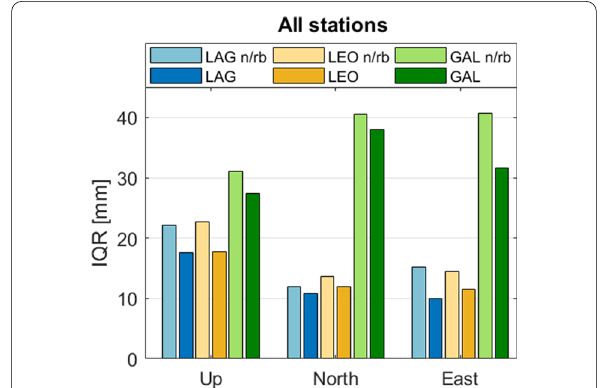
Fig. 6 Repeatability of estimated station coordinates by the means of IQR for LAGEOS (LAG), LEO satellites (LEO), and Galileo (GAL) with and without introducing annual range bias correction